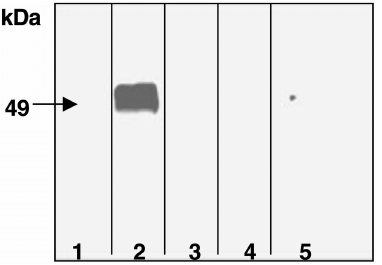
Figure 5. Proteinase K digestion for NoxA2 topology. Whole cells were treated with proteinase K and the NoxA2 remaining was ana- lyzed by immunoblot. Lane 1: wash from untreated whole cells; Lane 2: untreated whole cells; Lanes 3–5: whole cells treated with proteinase K for 10 (Lane 3), 20 (Lane 4) and 30 min (Lane 5).